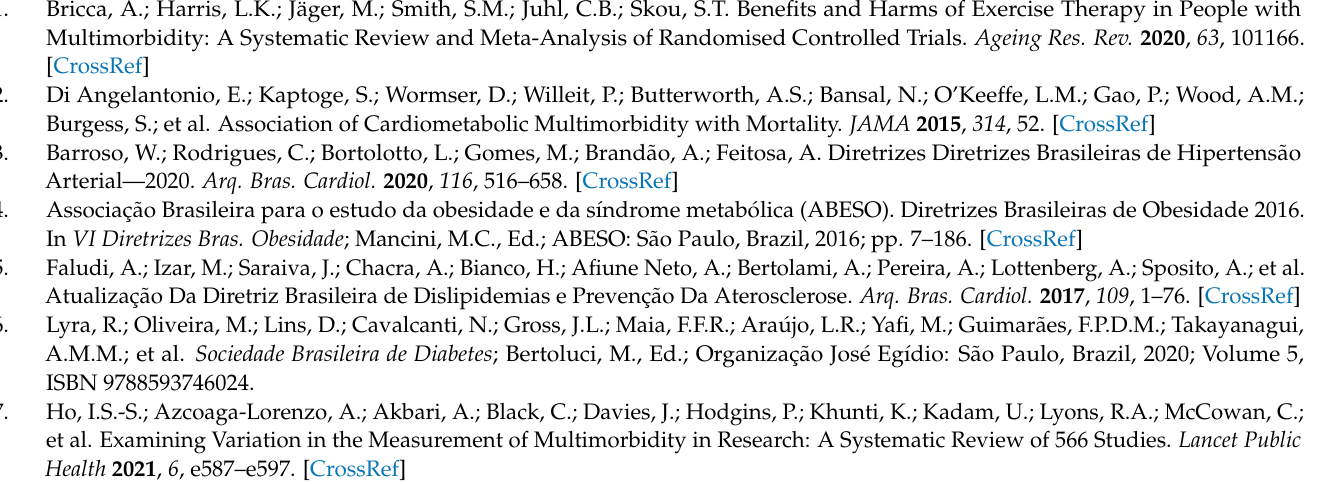
Table S2: Analysis of food consumption pattern in SINGLE ( n = 13) and MULT ( n = 20) before and after 12 weeks of Mat Pilates